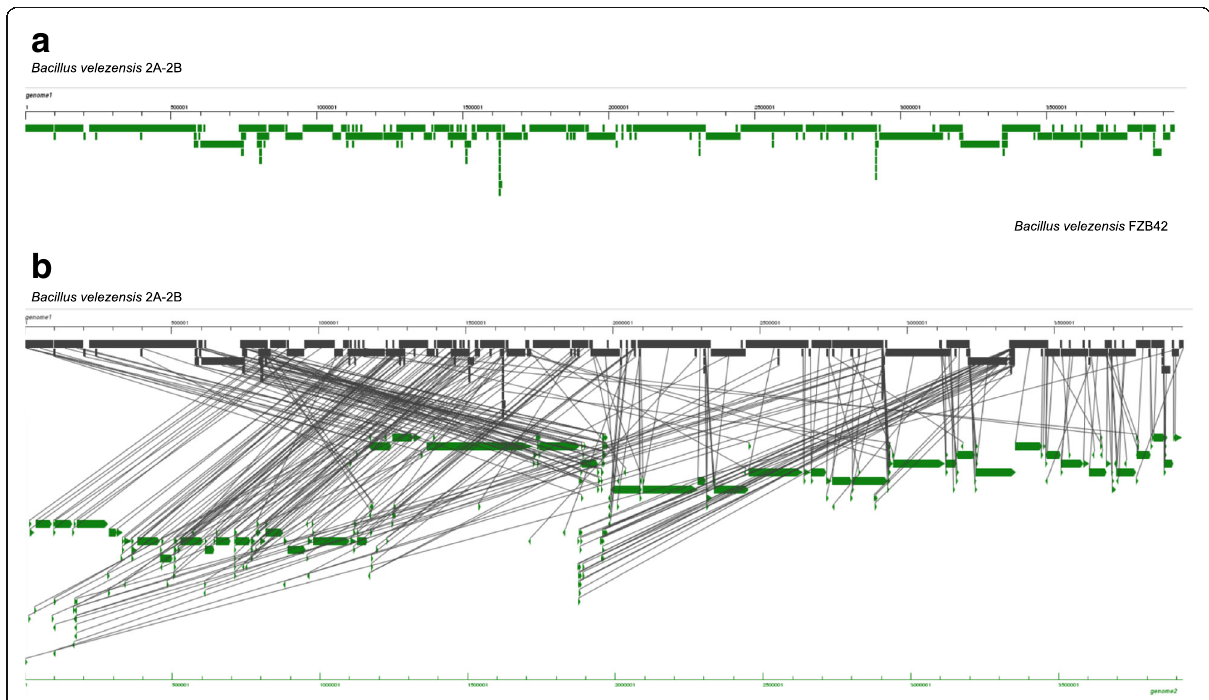
Fig. 6 Synteny analysis between B. velezensis 2A-2B and B. velezensis FZB42 genomes. The B. velezensis FZB42 (acc: NC_009725.1) as reference genome. In a , synteny of 2A-2B strain vs. FZB42 strain. Blocks of synteny along the reference genome, and remarkable synteny with the sense DNA strand of 2A-2B strain is shown. In b , rearrangements of genomic segments in the 2A-2B strain in comparison to the genome of